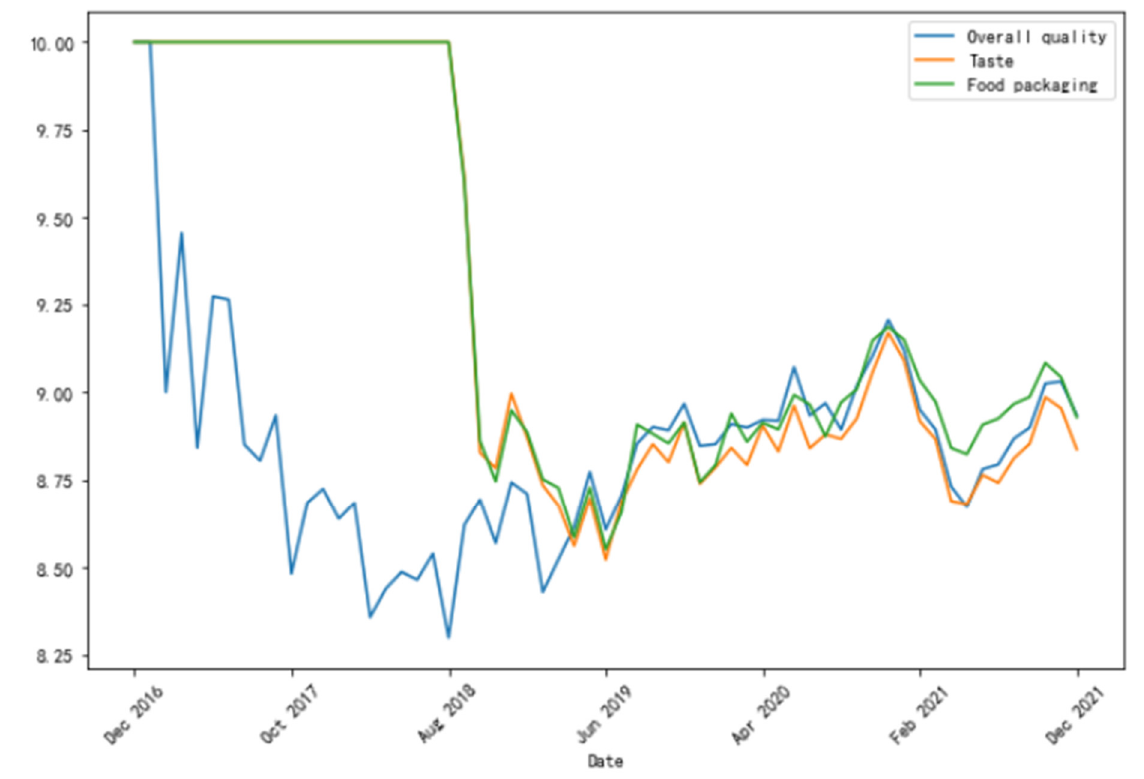
Figure 3. Customer ratings. Table 3. Reasons for providing third-party and in-house delivery